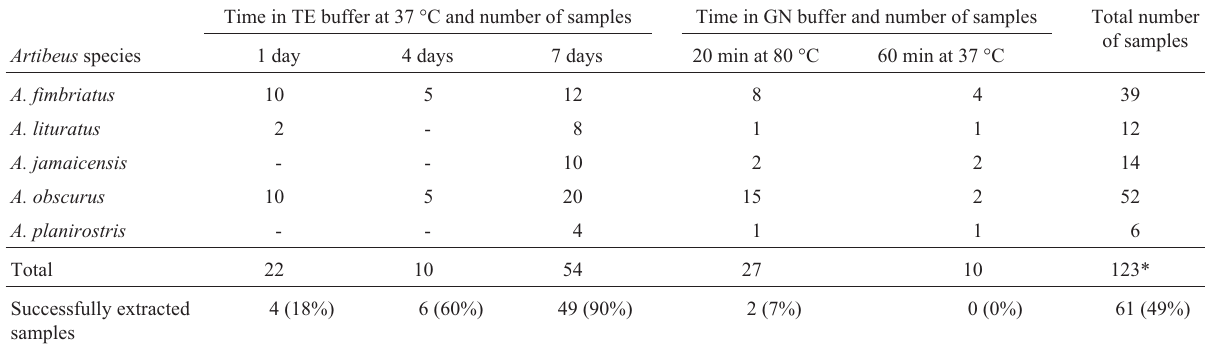
Table 3 - Combined number of formalin-fixed muscle and liver samples from preserved voucher specimens of Artibeus frugivorous bats tested in each treatment and the number (% in parentheses) of successfully extracted samples. The samples were held in 5 mL pH 8.0 Tris-EDTA buffer (TE, contain- ing: 0.01 M Tris, 0.001 M EDTA), changed every 48 h, or 5 mL pH 10.6 glycine-NaOH (GN: 0.2 M glycine, 0.2 M NaOH). A dash (-) indicates that the specified time was not used for samples from that species. Time in TE buffer at 37 °C and number of samples Time in GN buffer and number of